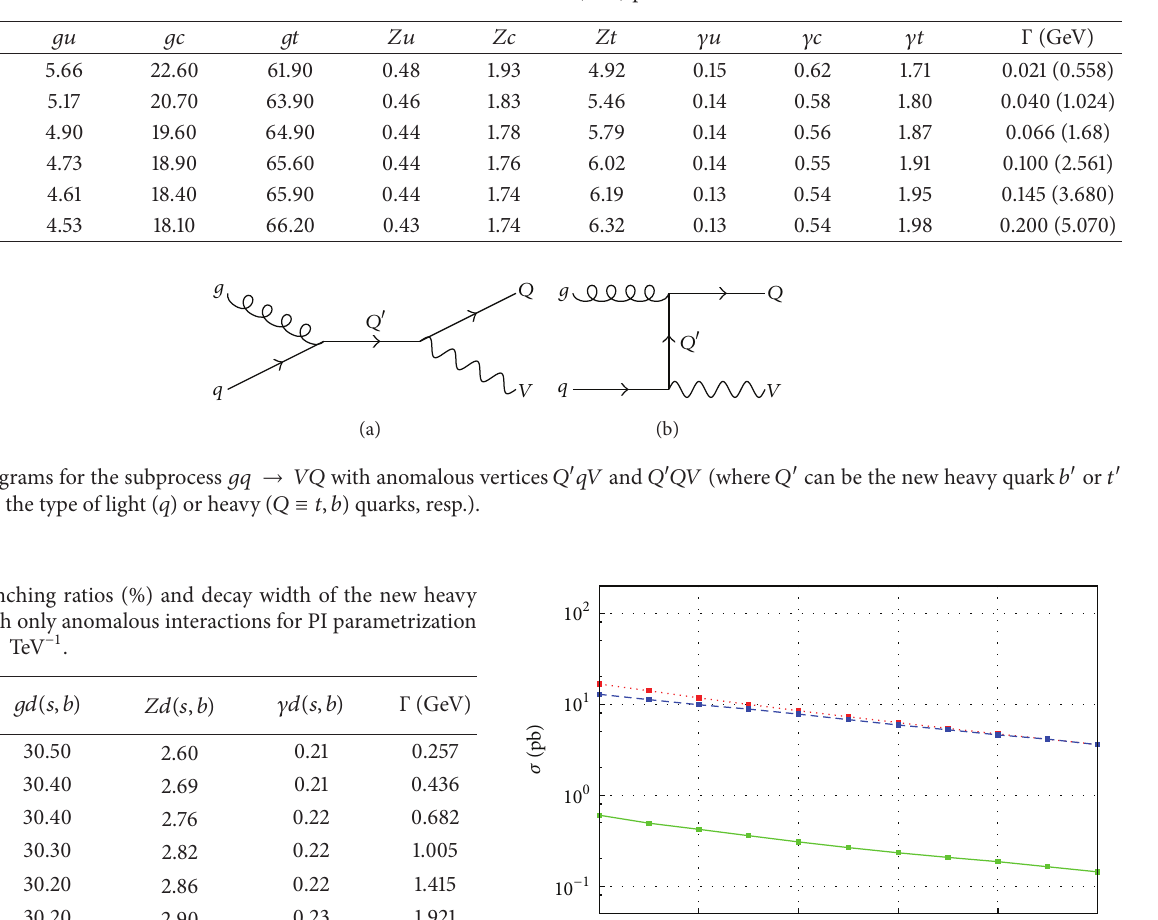
Table 2: The same as Table 1, but for PII (PIII) parametrization.